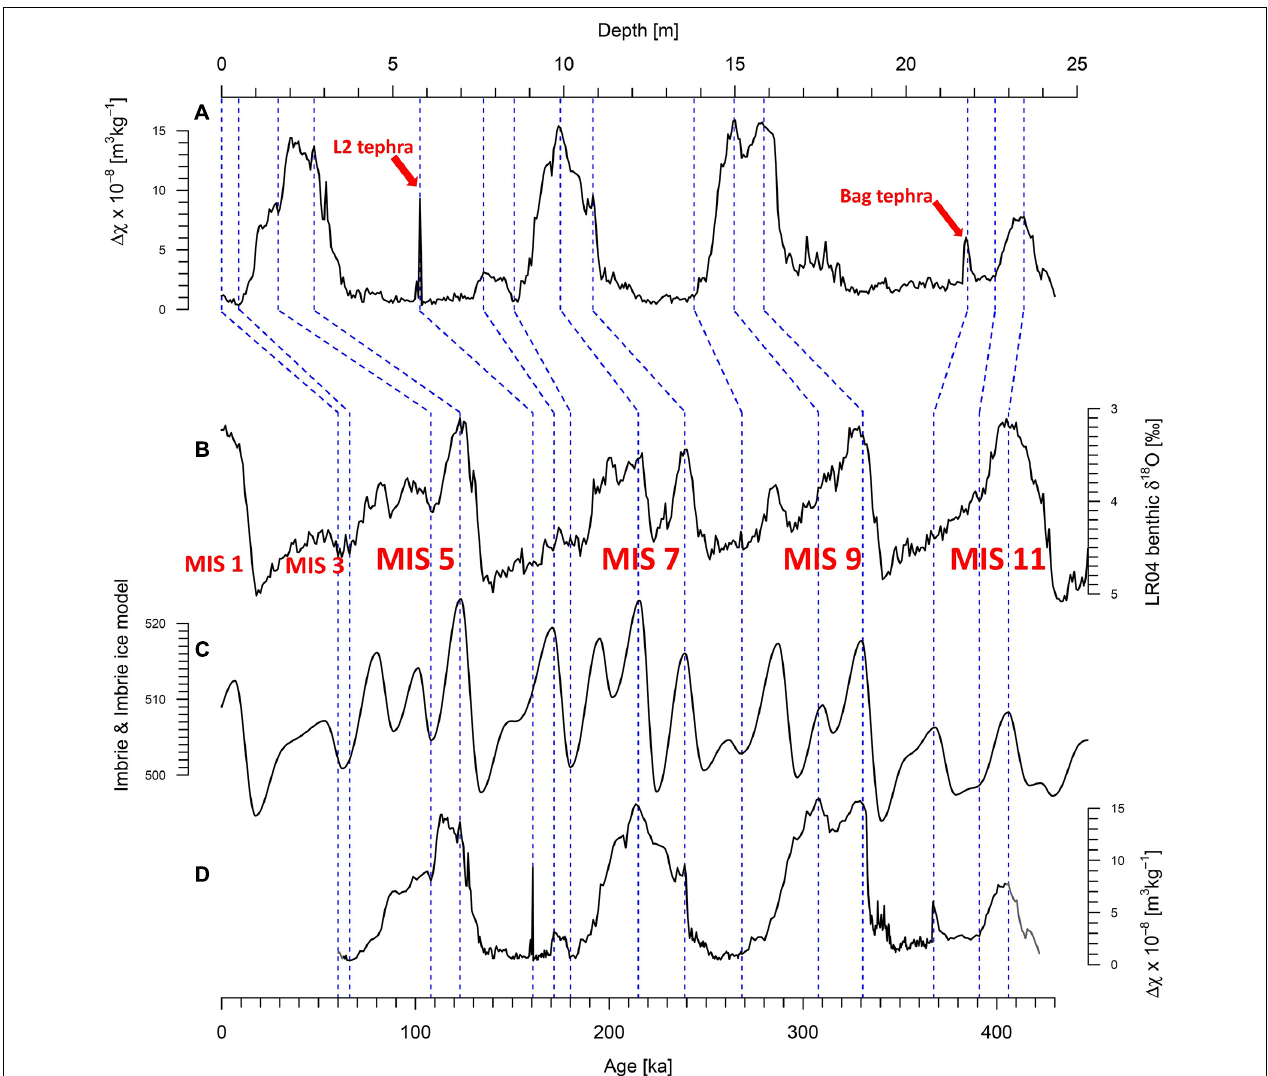
FIGURE 9 | Age model based on the correlation of absolute frequency dependent magnetic susceptibility values ( (cid:49) χ ) with LR04 (Lisiecki and Raymo, 2005) and Imbrie and Imbrie Ice model (Imbrie and Imbrie, 1980). (A) (cid:49) χ as function of stratigraphy. (B) Extract of the LR04 stack (last 430 ka). (C) Imbrie and Imbrie ice model (last 430 ka). (D) The age-tuned (cid:49) χ record based on the 15 tie-points, indicated by dashed lines (see Table 1